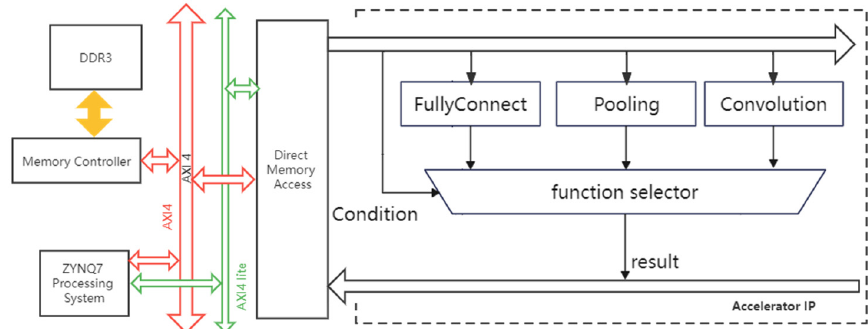
Figure 10. The overview PL system design.